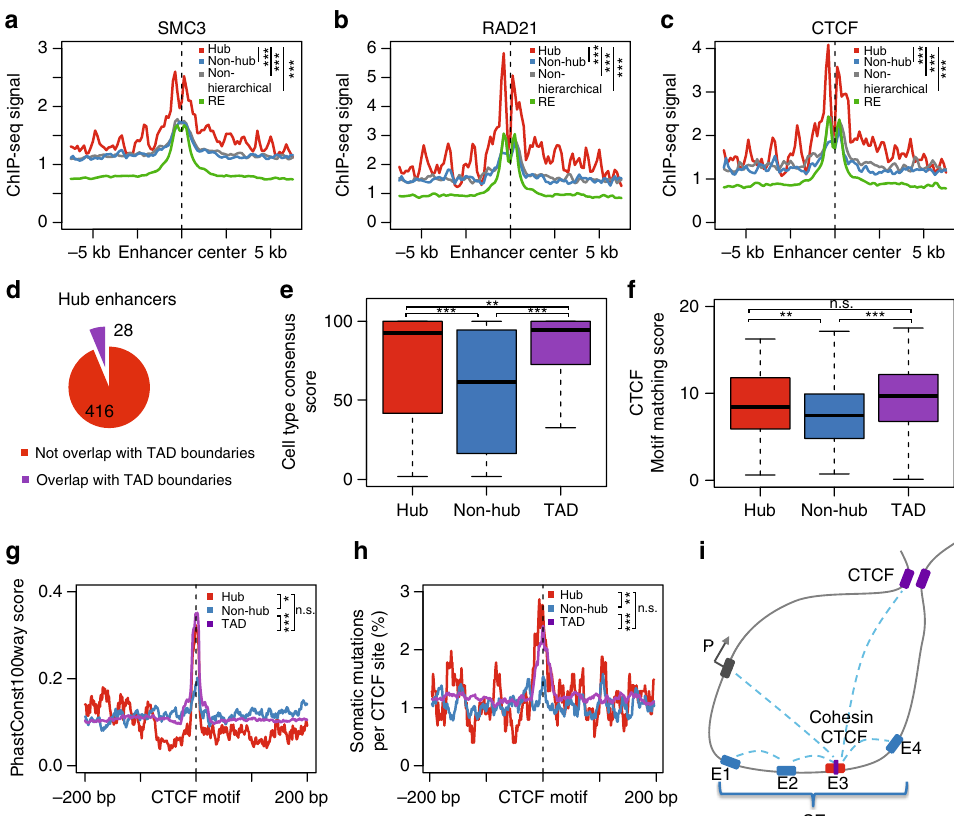
Fig. 3 CTCF binding at hub enhancers within hierarchical SEs in K562 cells. a – c Spatial distribution of two cohesin components SMC3 ( a ) and RAD21( b ), and CTCF ( c ), centered by enhancers in four groups. P values were calculated using Student ’ s t -test based on the ChIP-seq signal intensity of 1 kb window centered by enhancers. *P < 0.05 ; **P < 0.01 ; ***P < 0.001, n.s. not signi fi cant. d Percentage of hub enhancers with (purple) or without (red) overlapping with TAD boundaries collected from the literature 15 . The CTCF ChIP-seq peaks/motif-sites associated with hub enhancers overlapping with TAD boundaries were excluded for analysis in e – h . e,f CTCF binding consensus across cell types ( e ) and CTCF-motif-matching score ( f ) of CTCF peaks in different contexts: hub (red), non-hub enhancers (blue) and TAD boundaries (purple). For each CTCF peak in K562, the consensus score (y-axis) was quanti fi ed as the percentage of cell types containing the same CTCF peak. In box plots, the center line represents the median, the box limits represent the 25th and 75th percentiles and the whiskers represent the 5th and 95th percentiles. P -values were calculated using Student ’ s t- test. *P < 0.05 ; **P < 0.01 ; ***P < 0.001, n.s. not signi fi cant. g Sequence conservation around CTCF motif sites. The sitepro plots were centered by CTCF motif sites. P values were calculated using Student ’ s t -test based on the PhastConst100way score ( y -axis) within CTCF motif sites. *P < 0.05 ; **P < 0.01; ***P < 0.001, n.s. not signi fi cant. h Somatic mutation rate in cancers collected from IGGC around CTCF motif sites. The sitepro plots were centered by CTCF motif sites with 10 bp smoothing window. P -values were calculated using Fisher ’ s exact test based on overlap between CTCF motif sites and somatic mutation sites. *P < 0.05; **P < 0.01; ***P < 0.001, n.s. not signi fi cant. i Model of the hierarchical organization of SEs containing both hub and non-hub enhancers. A hub enhancer is highly enriched with CTCF and cohesin binding, and functions as an organization hub to coordinate the non-hub enhancers and other distal